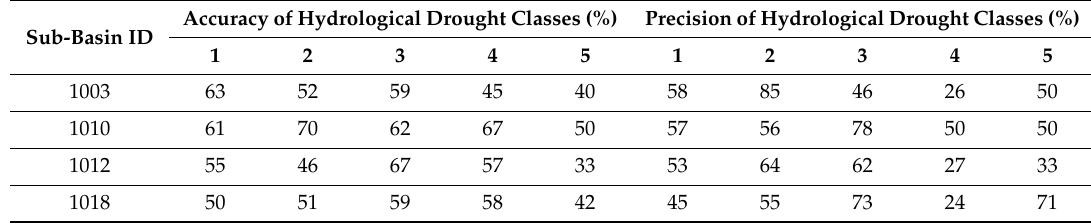
Table 4. Accuracy and precision of the MBC in the classification of hydrological drought classes. Sub-Basin